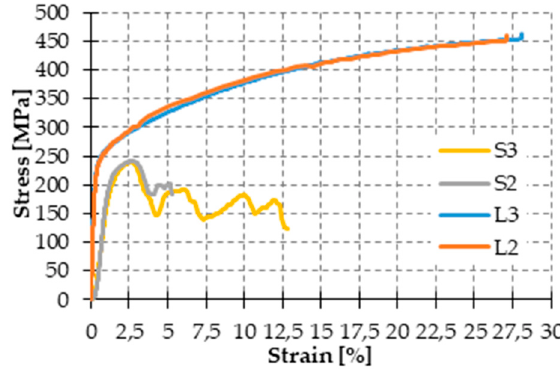
Figure 29. Stress/strain diagrams of the CAM-like ribbons, with and without seals.